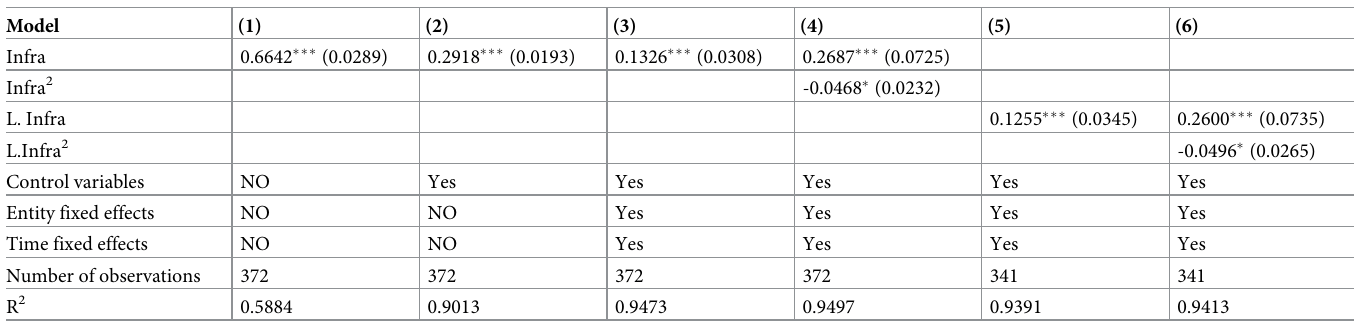
Table 5. The impact of infrastructure on overall tourism